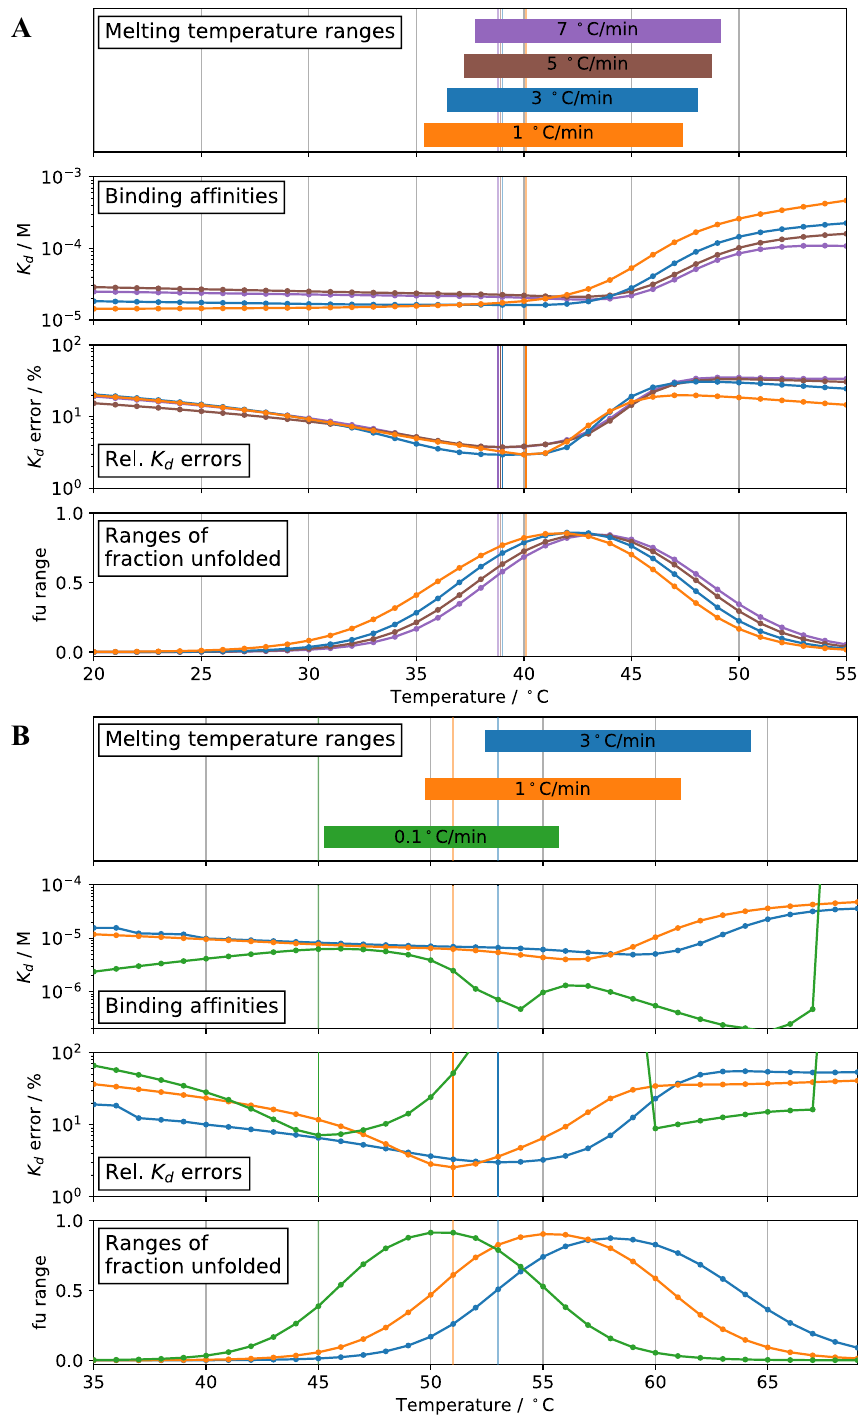
Figure 8. Isothermal analysis at different heating rates for Pcs60/ γ S-ATP ( A ) and SS1/ADPR ( B ). For all datasets, the ∆ C p = 0 was assumed. The binding affinities were extracted at the temperature with minimum K d fitting error marked by vertical lines (lines are horizontally shifted for visibility). All temperature and values are summarized in Table 3. The analyses for a fitted ∆ C p for a heating rate of 1 °C/min (cf. Table 1) are shown in Supplementary Information